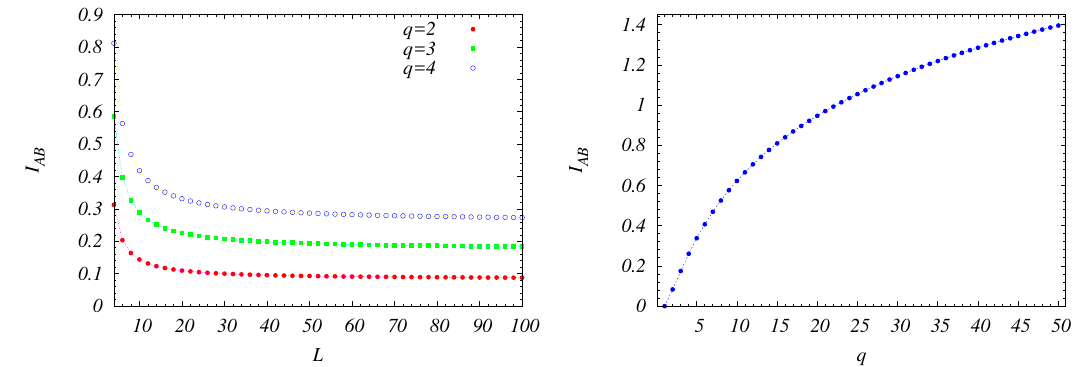
Figure 6: (Left) Mutual information between two spins at the edges of colorful Fred- kin chains, as a function of the size L , for different values of q . (Right) Mutual Information at long distance, L → ∞ , between two spins at the edges of colorful Fredkin chains, as a function of the color number q .